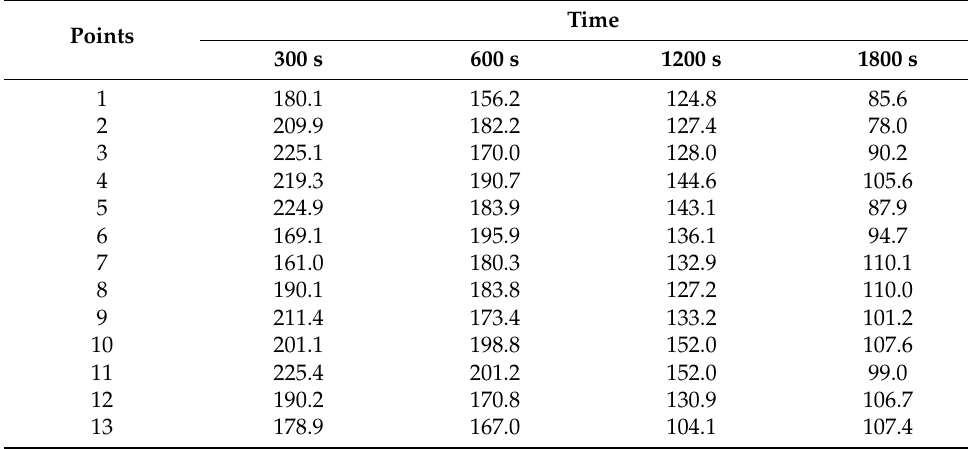
Figure A1. The simulation results of case 1 at the time of ( a ) 300 s; ( b ) 600 s; ( c ) 1200 s; ( d ) 1800 s. Table A1. Quantitative results of case